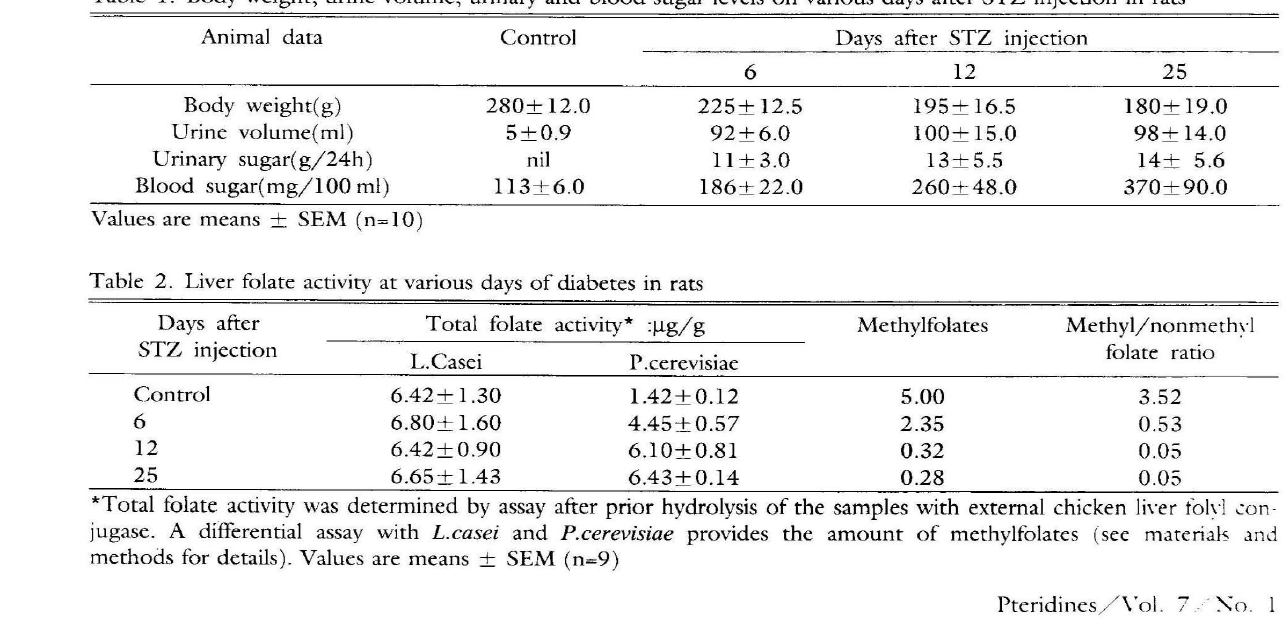
Table 1. Body weight, urine volume, urinary and blood sugar Ieveis on various days after STZ injection in rats Animal data